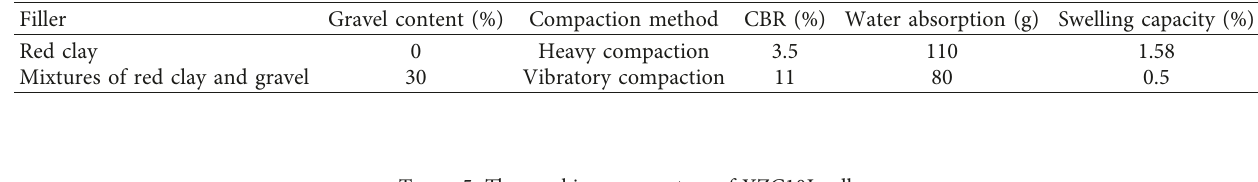
Table 4: The results of CBR test.